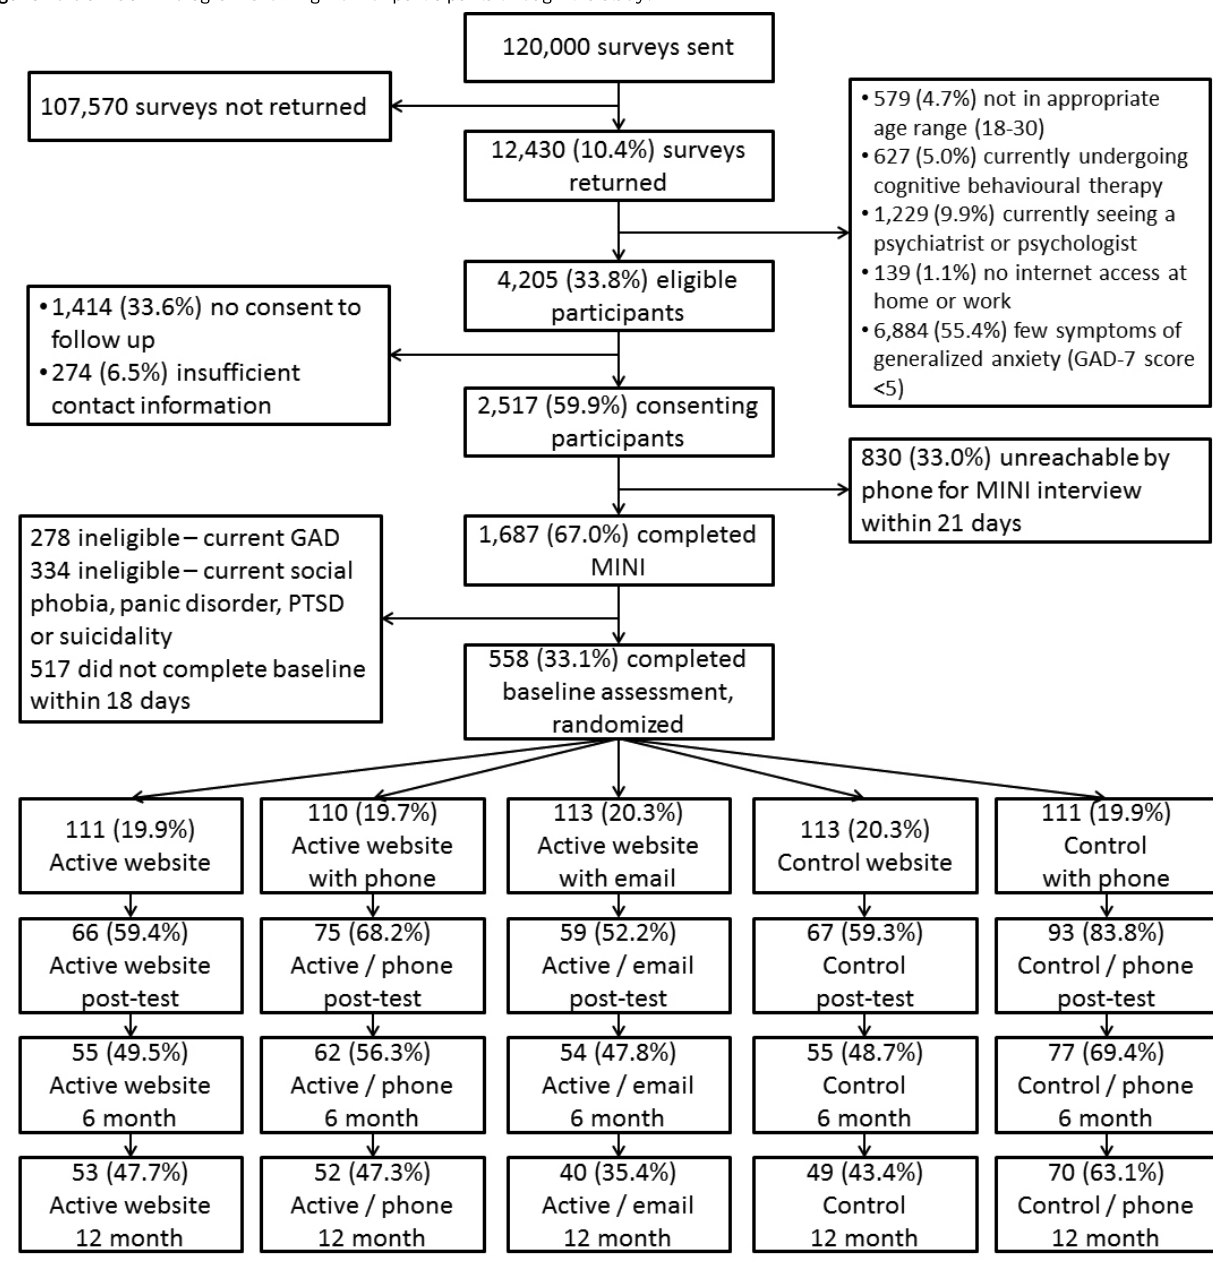
Figure 1. CONSORT diagram showing flow of participants through the